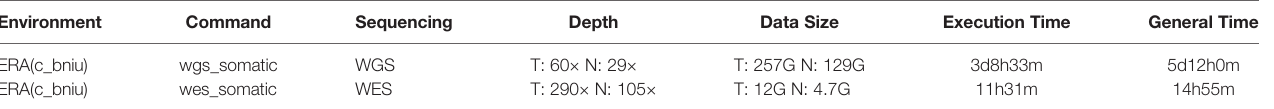
TABLE 3 | Execution time statistics of DIVIS.